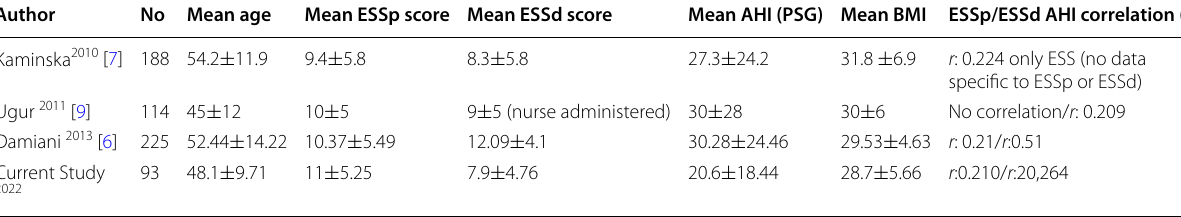
Table 5 A summary of the related